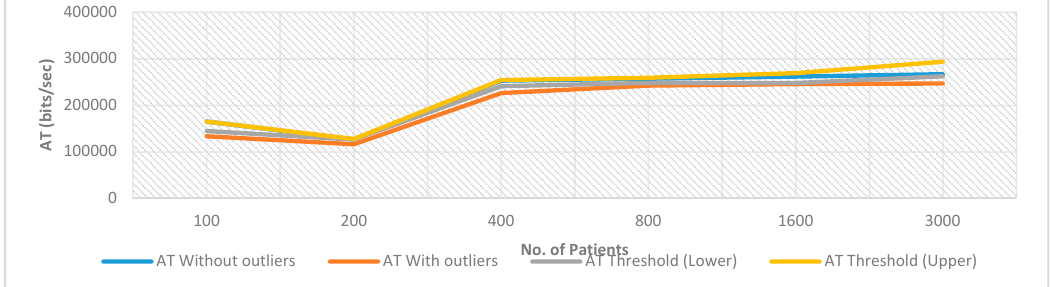
Figure 41. Average throughput (AT) for Proposed IoT-Sensor based network.